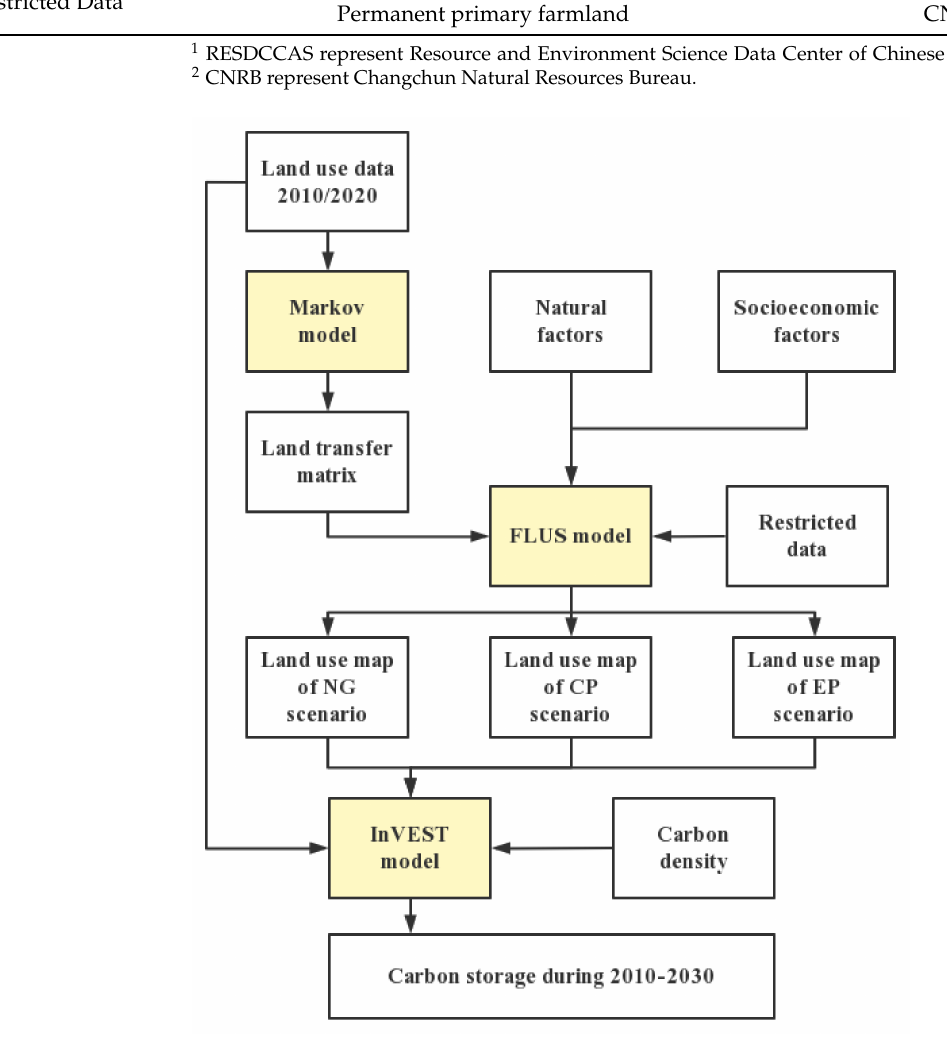
Figure 2. The research